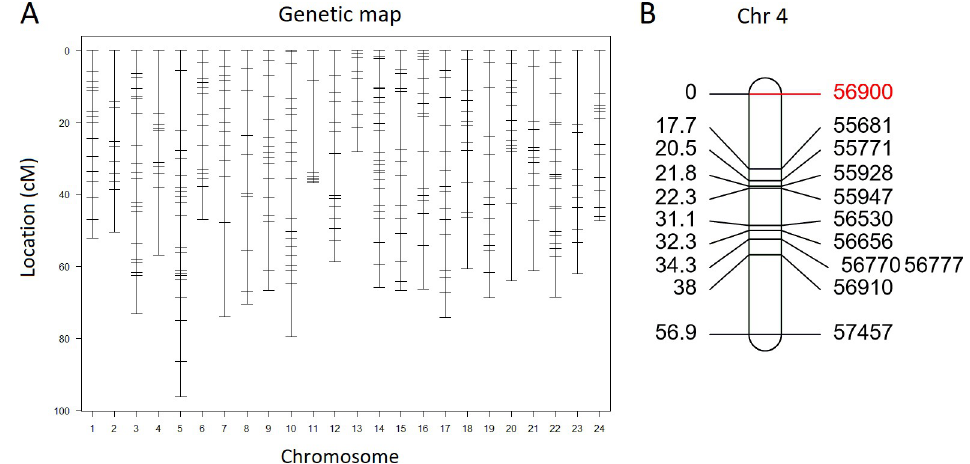
Fig 3. Genetic map of the single nucleotide polymorphism (SNP) markers. (A) Marker distribution across the 24 medaka chromosomes. (B) Genetic map of chromosome 4 show the marker names and locations (cM). Markers with the highest logarithm of odds (LOD) scores in the QTL analysis are shown in red.